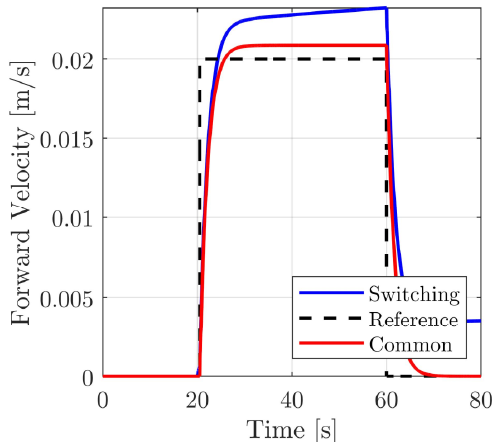
Figure 9. Forward velocity of the vehicle.